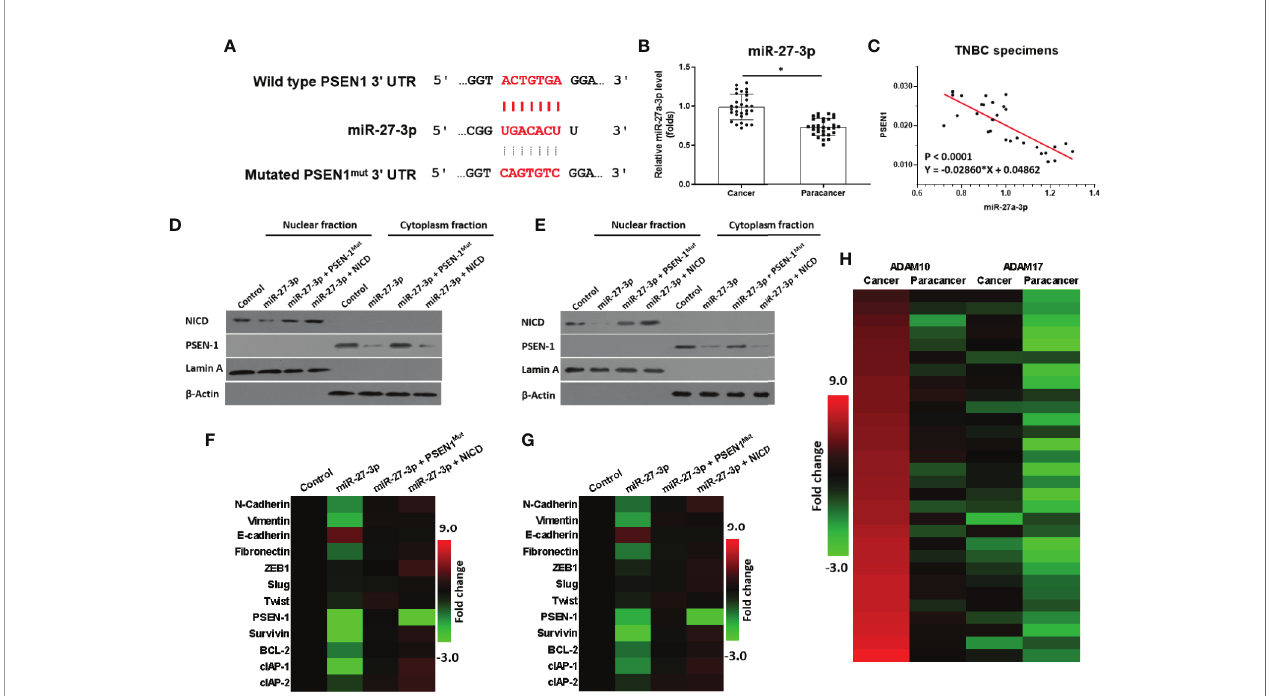
FIGURE 1 | miR-27-3p targets the 3 ’ UTR of PSEN-1. (A) miR-27-3p has the potential to target the 3 ’ UTR of PSEN-1. (B) The expression of miR-27-3p in TNBC or the paired non-tumor tissues, as determined by qPCR, is presented as a scatterplot. (C) The correlation between miR-27-3p and PSEN-1 in TNBC tissues is presented as a scatterplot. (D, E) HCC1937 (D) or MDA-MB-436 (E) TNBC cells were transfected with plasmids, and the subcellular fraction was harvested. The protein expression of PSEN-1 or NICD was examined via western blotting. Lamin A was used to indicate the nuclear material, and b -actin was used to indicate the cytoplasm. (F, G) HCC1937 (F) or MDA-MB-436 (G) TNBC cells were transfected with plasmids and harvested for qPCR. The expression of the downstream genes of the Notch pathway are presented as a heat map. (H) The expression of ADAM-17 or ADAM-10 in TNBC tissues was examined by qPCR and is presented as a heat map. *P <